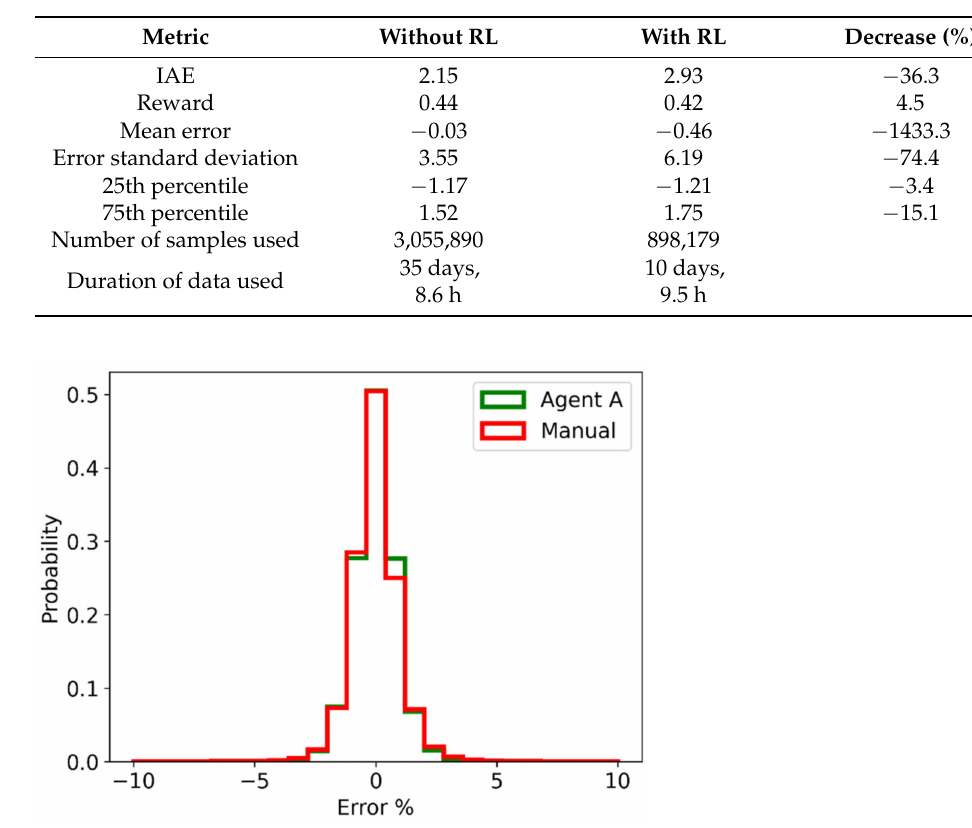
Table 6. Sump feed water control loop performance with and without the use of RL. The decrease percentage measures the decrease in the absolute value of the metric owing to the use of RL. Positive decreases indicate better performance, except for the reward, where an increase is expected.